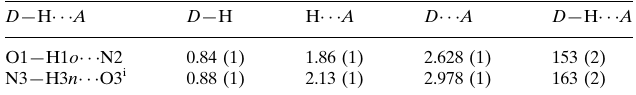
Hydrogen-bond geometry (A˚ , (cid:2)